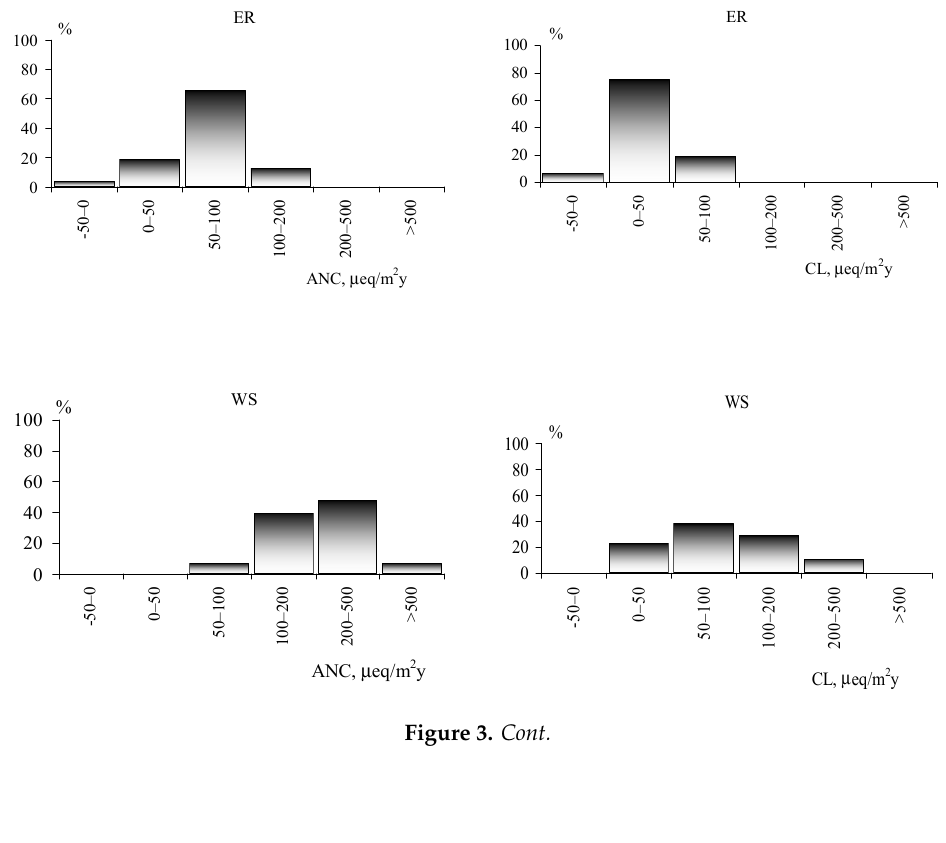
Figure 3. The percentage distribution of lakes according to the values of water acid-neutralizing capacity (ANC) and critical loads (CL) in the Arctic regions of the European territory of Russia (ER), Western (WS) and Eastern Siberia (ES). 4.3. The Critical Value of Anc for the Studied Regions Water acidification affects the biological communities of aquatic ecosystems. As the ANC of the waters of the Kola North decreases to 50 μ eqL − 1 (corresponding to a pH of 5.8–6.2), the proportion of acidobiontic and acidophilic species of diatoms increases, and lake zooplankton become dominated by acidification-resistant species, from the bottom communities: amphipods, gastropod mollusks and nymphs disappear. Amphipod, being a typical inhabitant of the natural oligotrophic waters of the